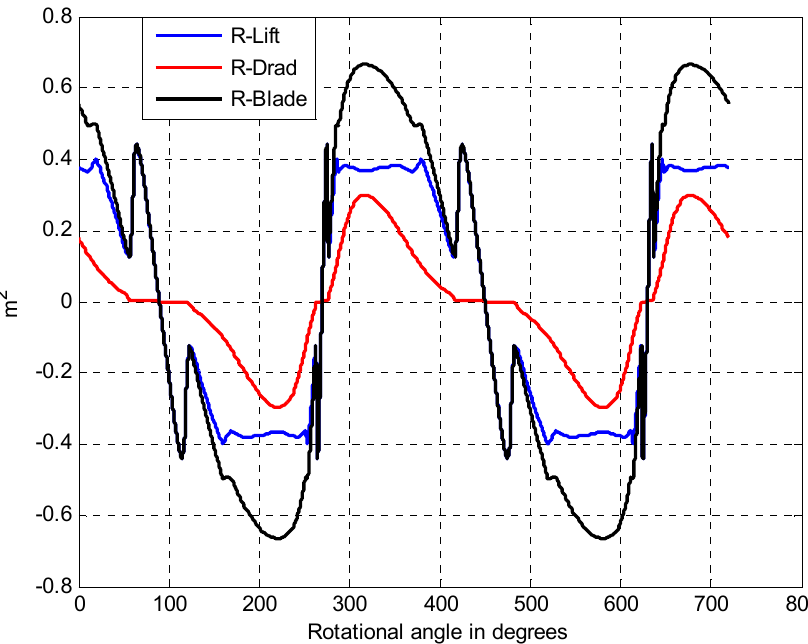
Figure 20. Lift, drag and normal resistance variations as functions of rotational angle.